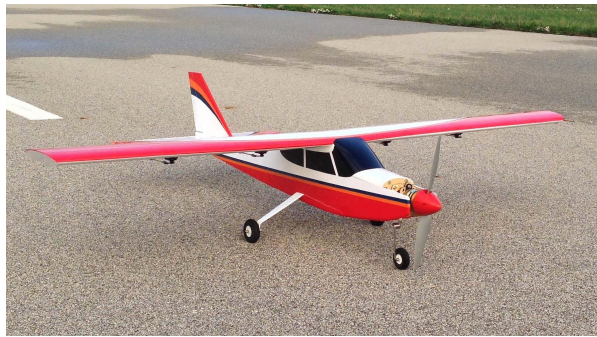
Figure 2. The flight-ready Avistar UAV testbed